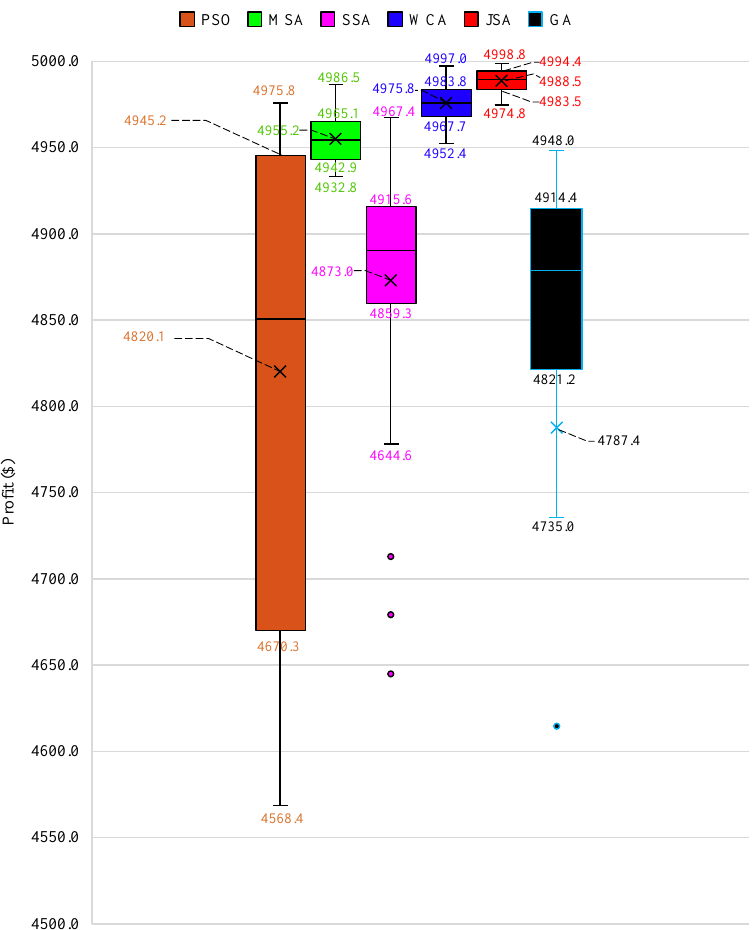
Figure 8. Summary of results obtained for Case 2.